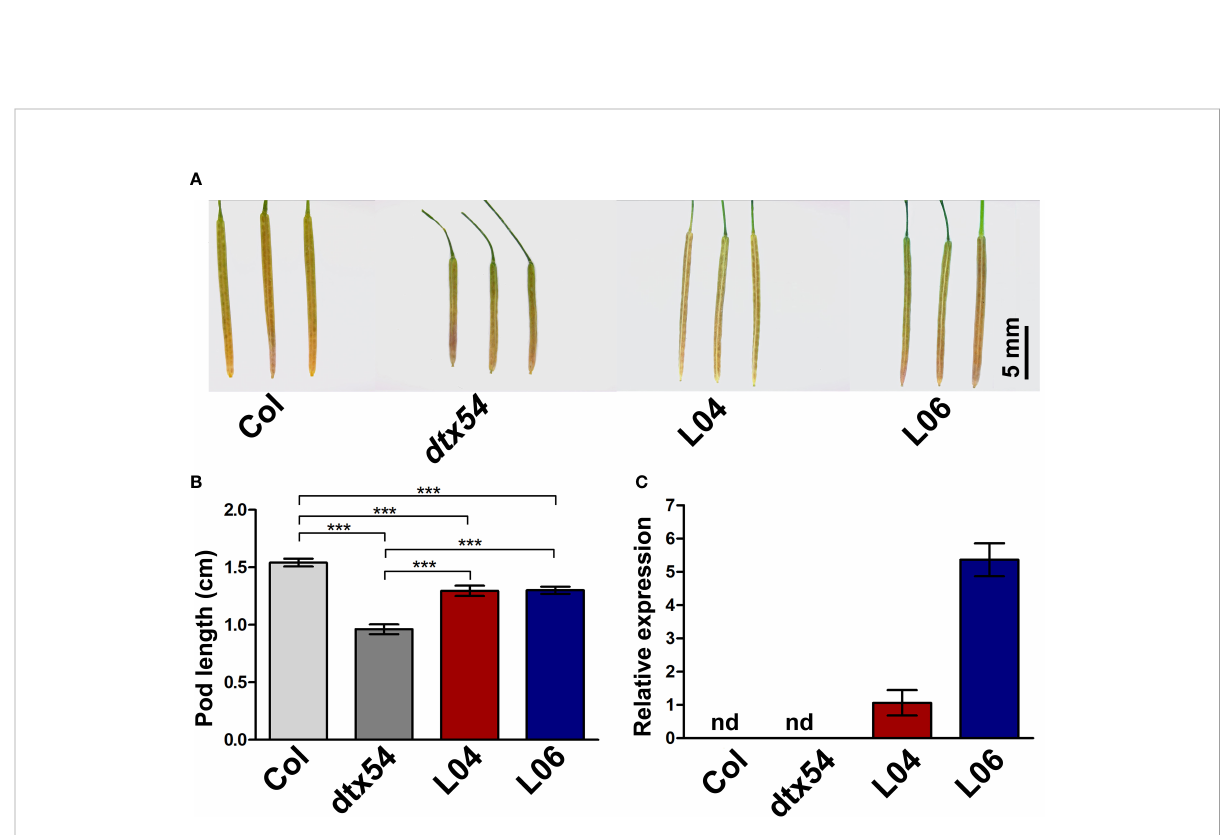
FIGURE 6 MIB1 partially rescued the shortened pod phenotype of Arabidopsis dtx54 mutant. (A) The pod phenotype of the wild-type plant (Col), dtx54 mutant, and 35S::MIB1 transgenic lines of dtx54 (L04 and L06). (B) The pod length of Col, dtx54 mutants, and two transgenic lines ( n = 100). (C) qRT-PCR analysis of MIB1 expression from Col, dtx54 mutant, and two transgenic lines. nd, not detected. The data were means ± SD. One-way ANOVA was used. *** p <